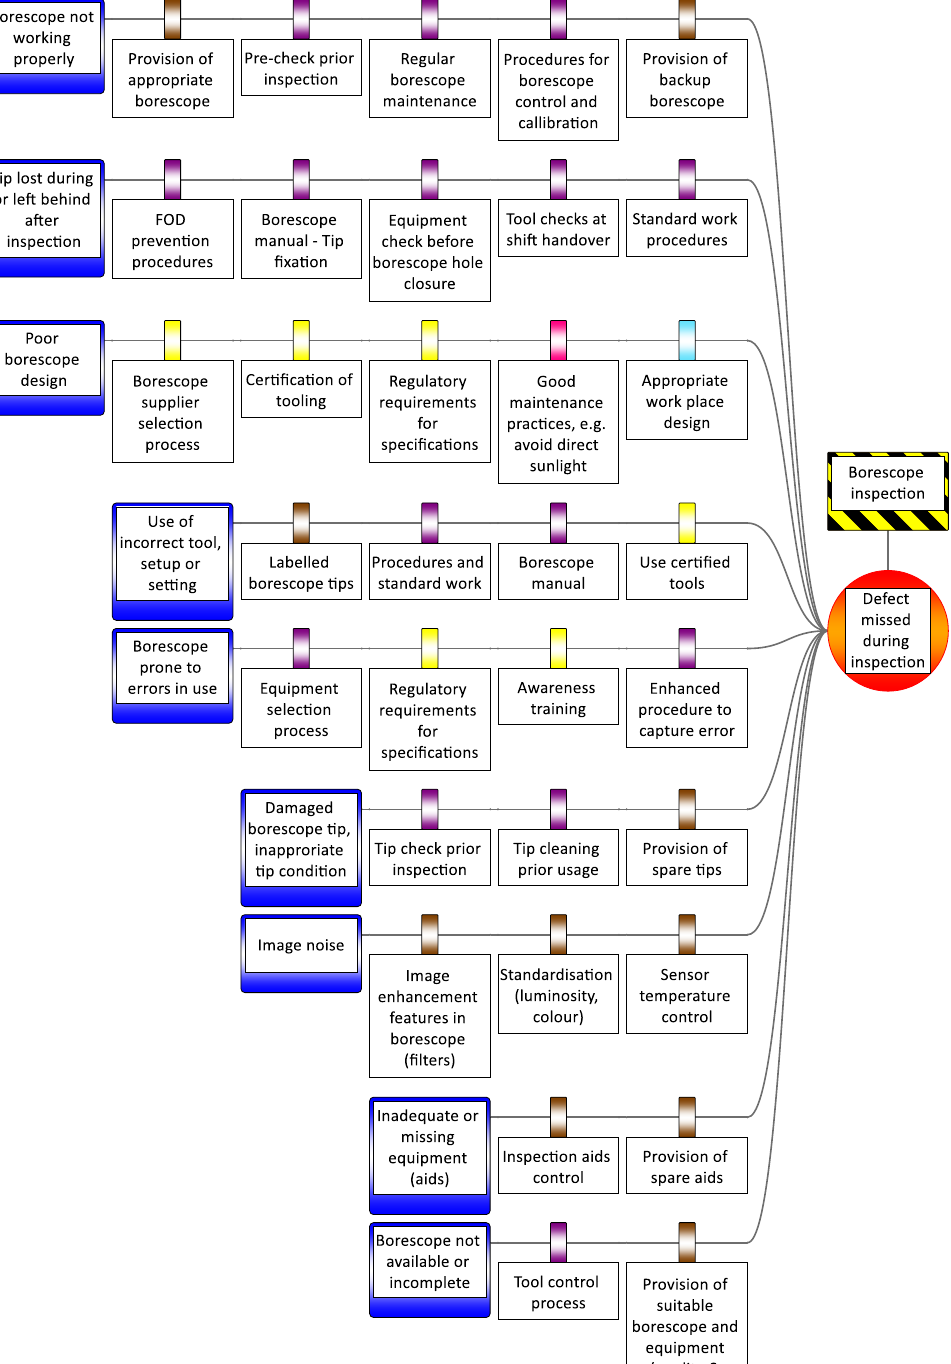
Figure A2. Machine-related threat paths with barriers.